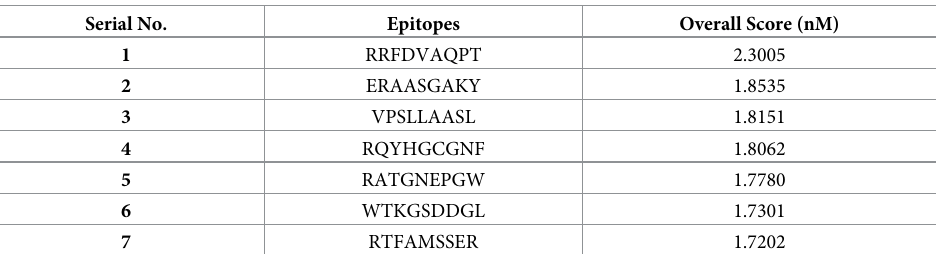
Table 5. NetCTL T cell epitope prediction with the combinatorial